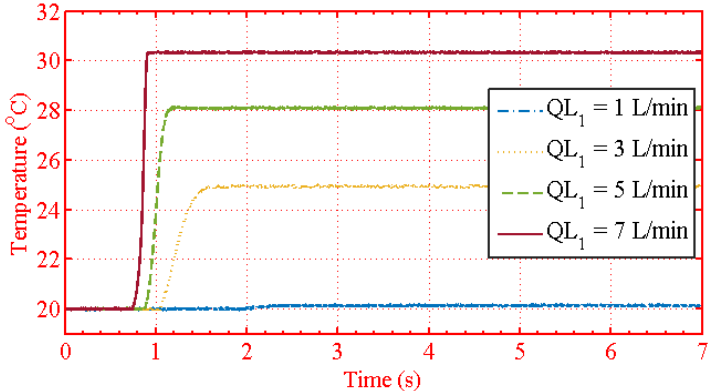
Figure 29. The output temperature in cold fluid with QL 2 = 7